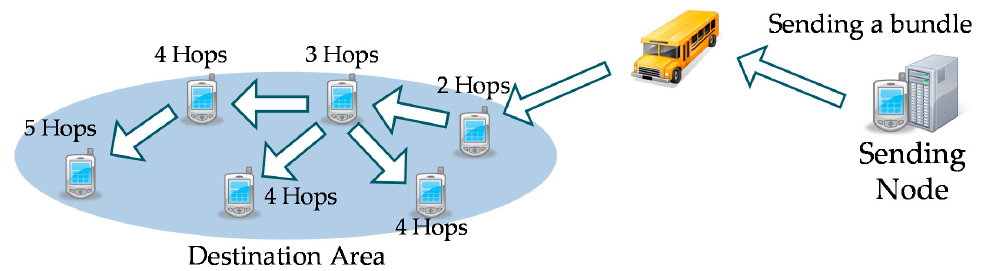
Figure 24. Percentage of the reduction in the number of copies.